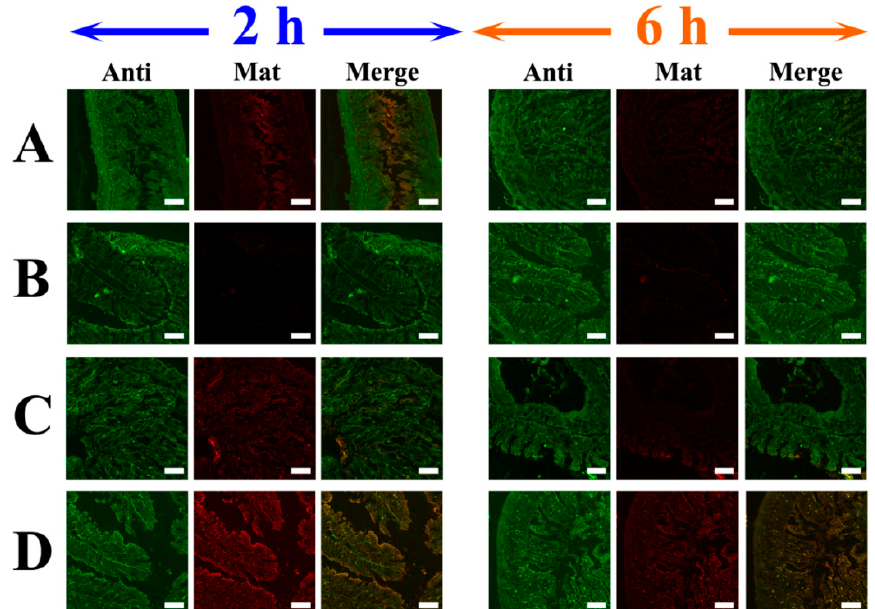
Figure 5. Rats’ intestines ultralow temperature slices after oral administration with ICG ( A ); TpPa-1 ( B ); TpPa-1@ICG ( C ); or TpPa-1@ICG-HG ( D ) for 2 h or 6 h. Then, the slices were further stained with LYVE-1 antibody (the second antibody was FITC labeled). The fluorescence of the antibody was displayed in green and the fluorescence of ICG, TpPa-1, TpPa-1@ICG, or TpPa-1@ICG-HG was displayed in red. Anti: antibody; Mat: material. The scale bars equal 200 μ m.